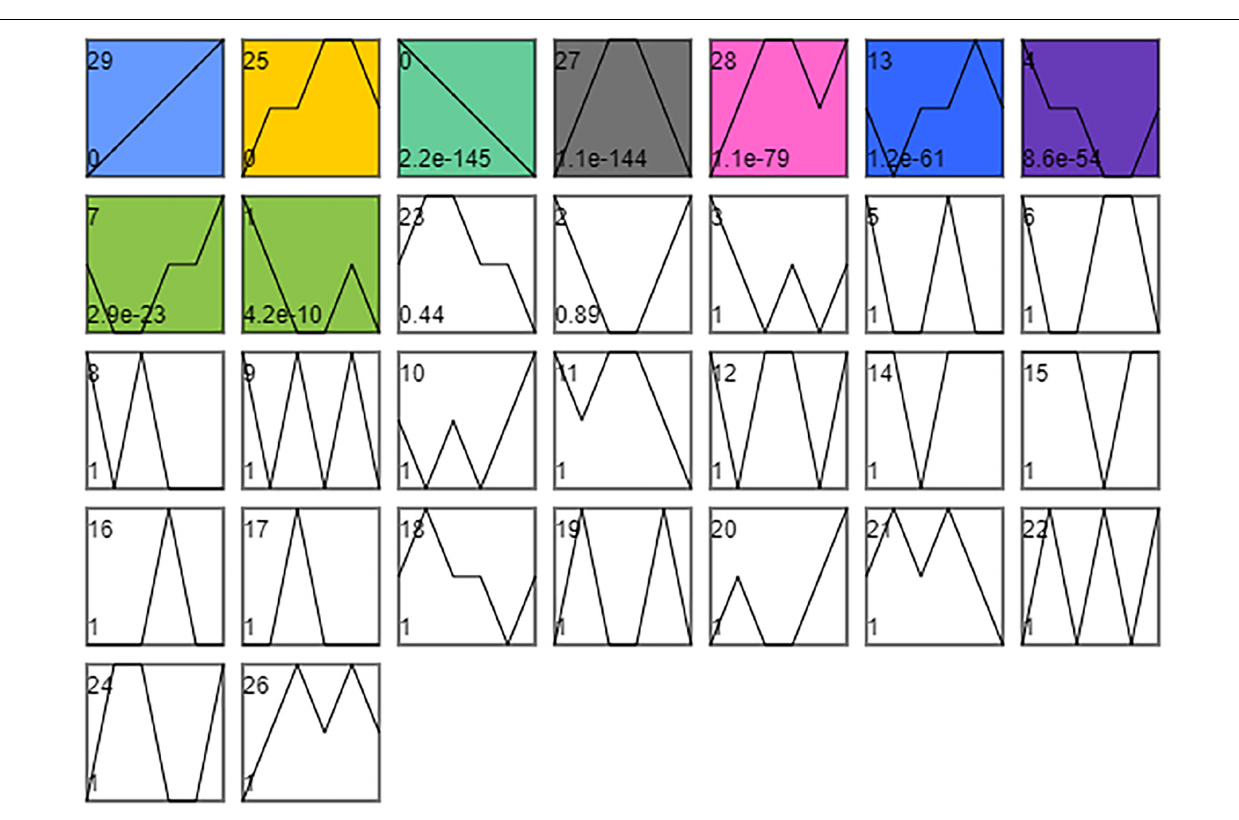
metabolic pathways were enriched ( P < 0.5;